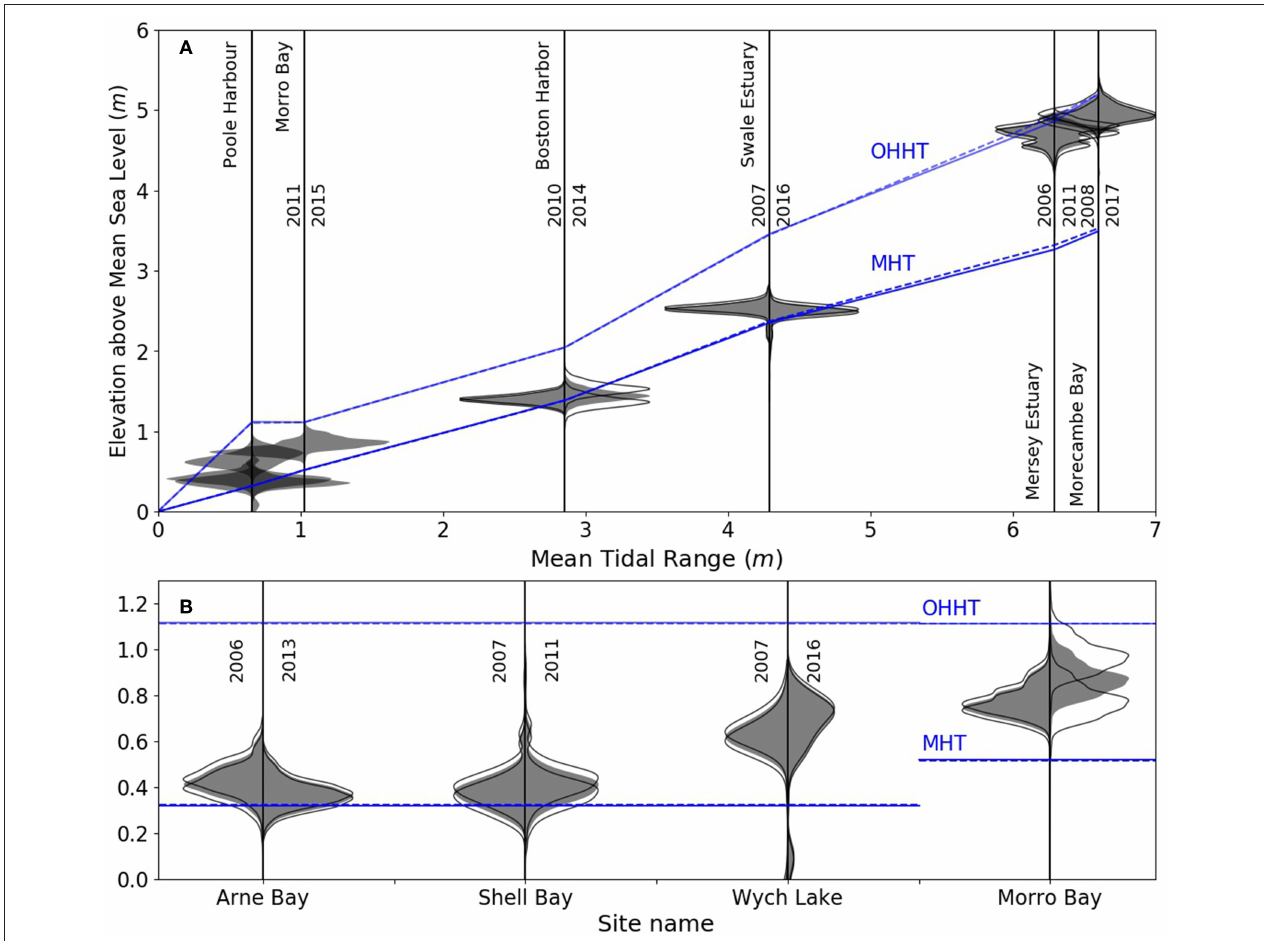
FIGURE 5 | Probability distribution functions of marsh platform elevations relative to MSL for each examined marsh at the dates S 1 (left - gray fill) and S 2 (right - gray fill); Black lines indicate the possible vertical offset of the probability distribution functions due to lidar vertical error; Blue lines show the monthly trend for MHT and OHHT a the dates S 1 (full) and S 2 (dashed); (A) Marsh sites organized by Mean Tidal Range. (B) Detail of micro-tidal